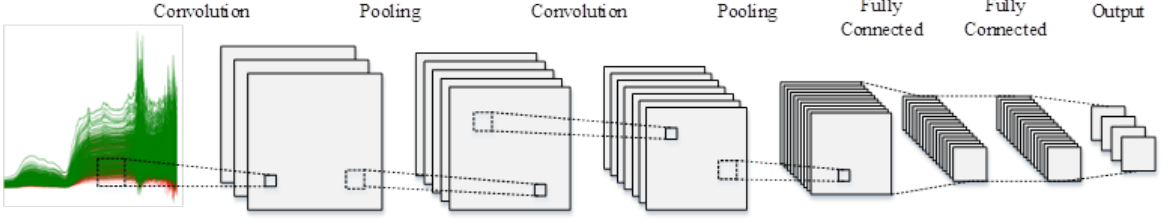
Figure 7. Schematic diagram of CNN algorithm.